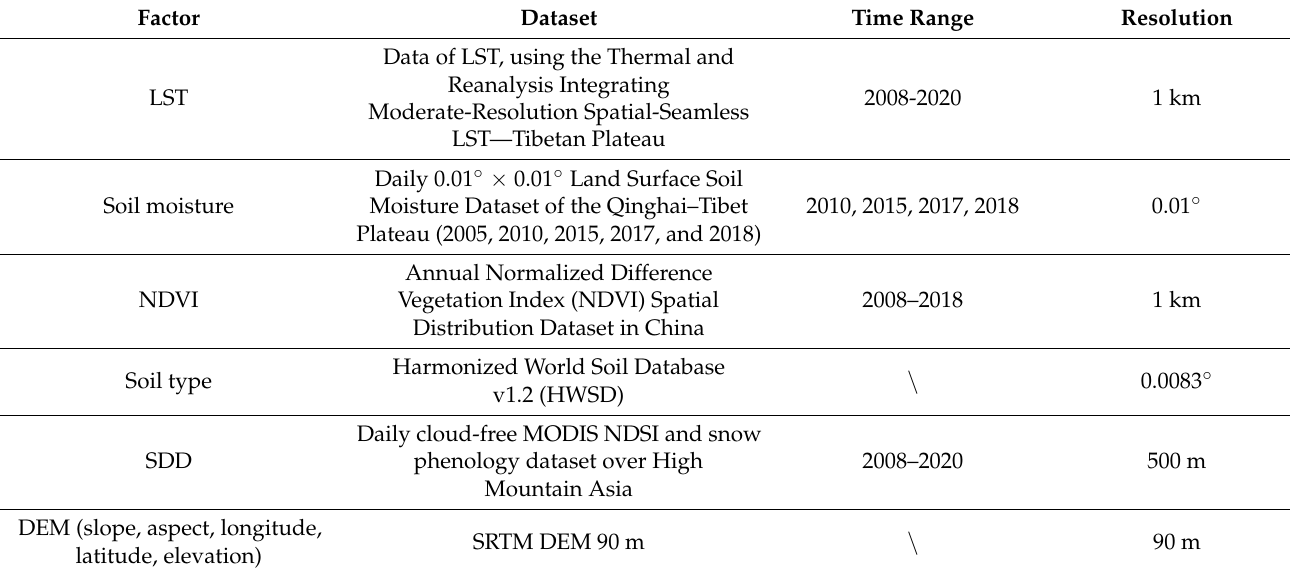
Table 1. Types of remote-sensing data and their